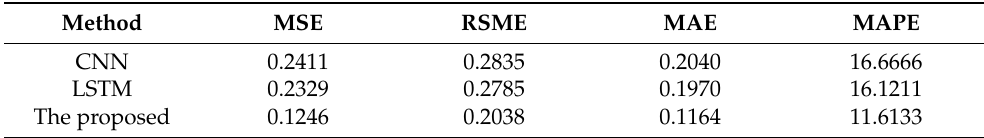
Table 10. Performance comparison of deep-learning methods.